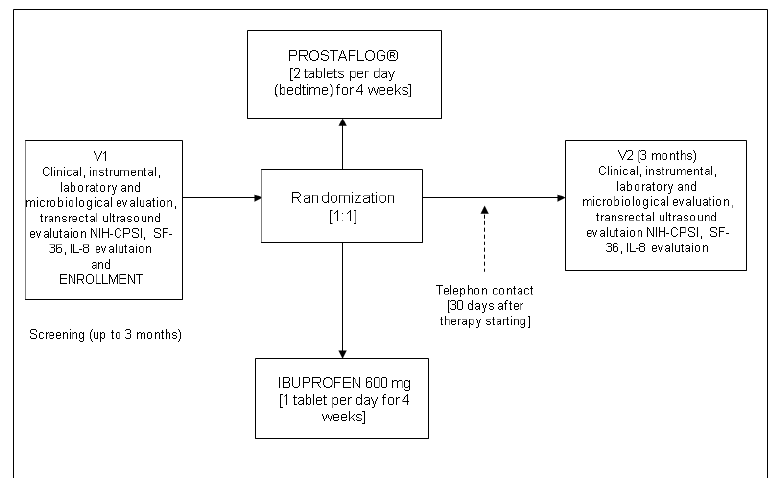
Figure 1. The study